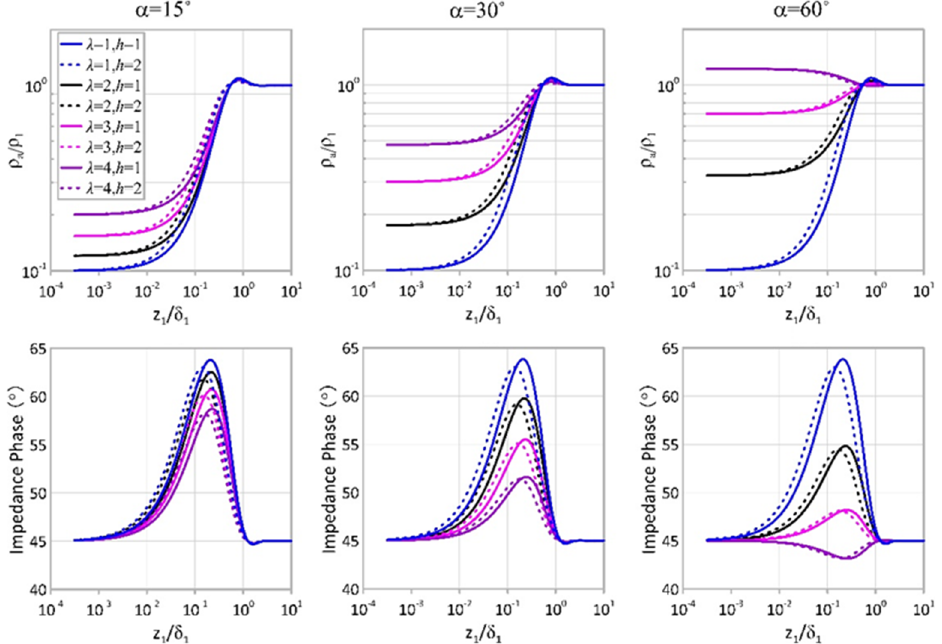
Figure 4. The normalized apparent resistivity (top panels) and impedance phase (bottom panels) at the surface of the vertical inhomogeneous and anisotropic Earth with various model parameters. ρ 1 is the resistivity of the first layer and the inverse of σ 1 ; δ 1 = 2/ ωµσ 1 is the skin depth of the incident EM wave with a given frequency and the conductivity in the top layer. The curves presented in the left, middle and right columns correspond to three different dip angles. In each panel, the results for different anisotropic coefficients are marked by curves in different colours, while those for the normalized thicknesses of 1 and 2 are marked by solid and dashed lines, respectively.